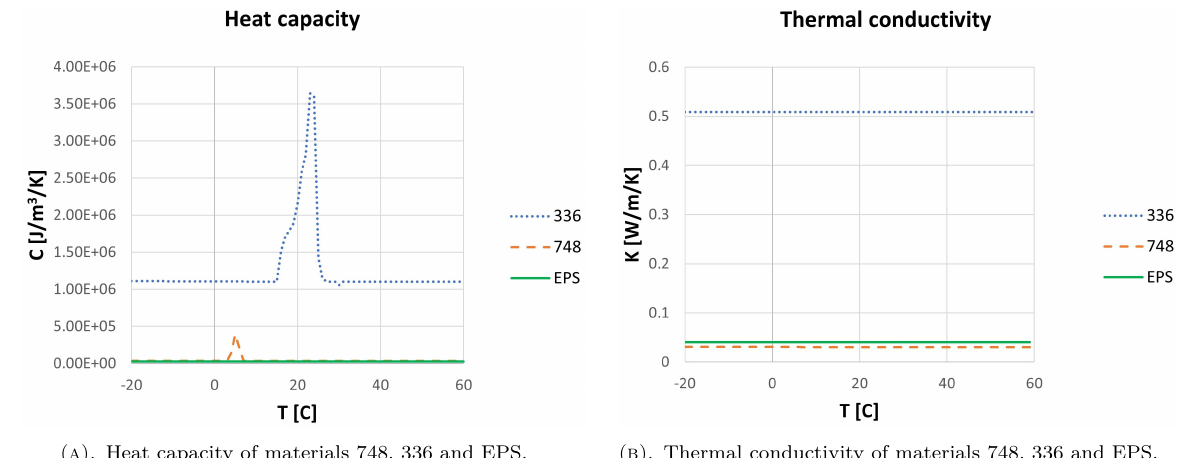
Figure 3. Thermal properties of studied materials.